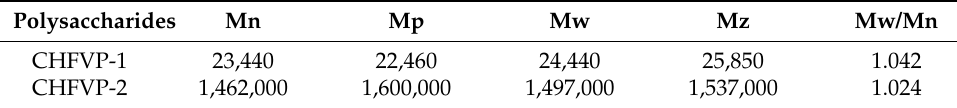
Table 1. Molecular weight of polysaccharides from F. velutipes